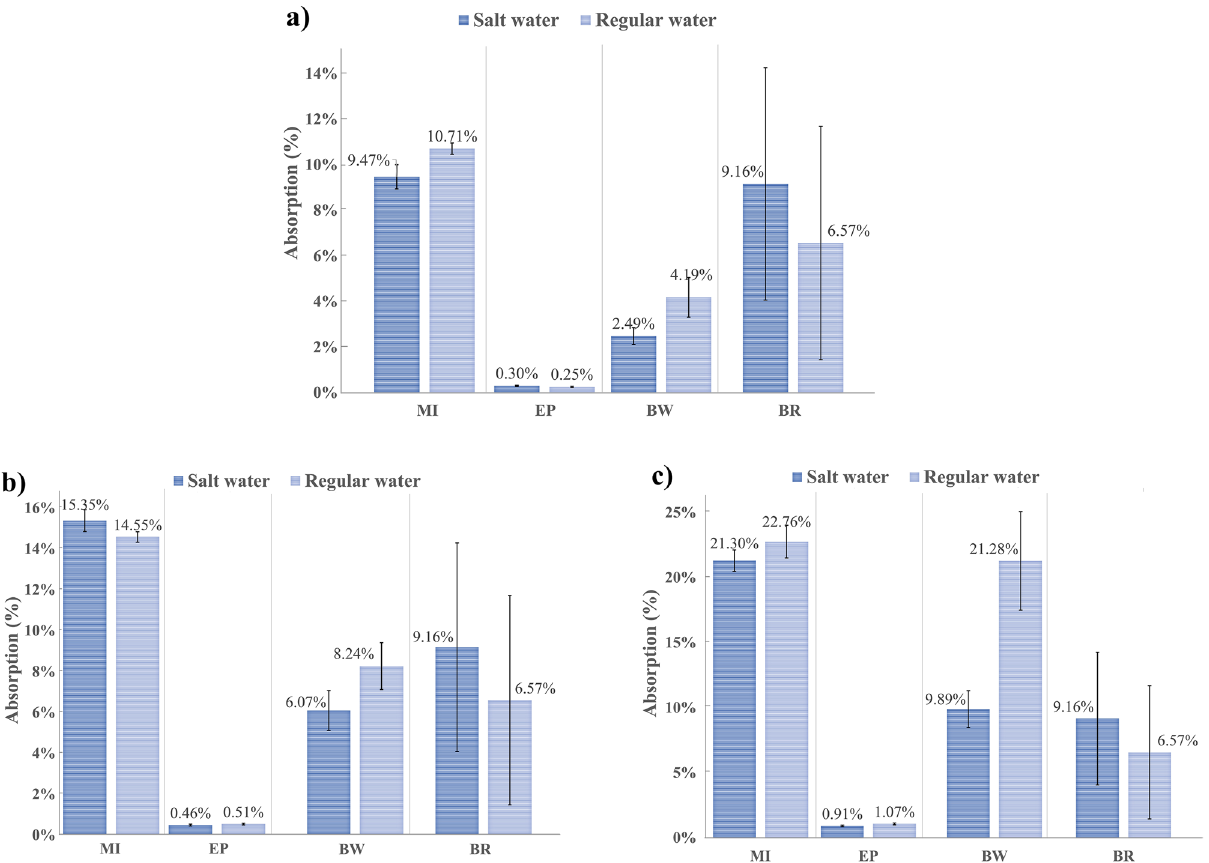
Figure 12. Average coating water absorption: ( a ) After 24 h ( b ) After 7 days ( c ) After 28 days.